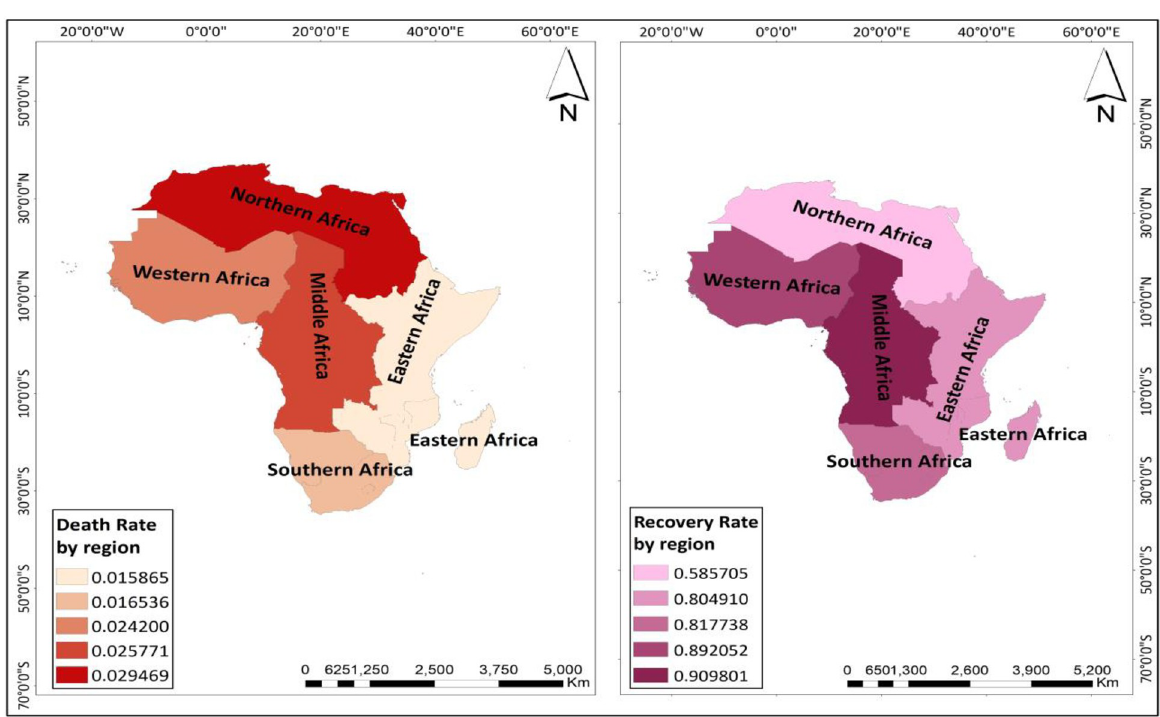
Fig 4. Maps showing the death rate (left) and recovery rate (right) by region of Africa (reprinted from https://tapiquen-sig.jimdofree.com/ descargas-gratuitas/mundo/, under a CC BY license, with permission from Carlos Efrain Porto Tapiquen, 2021).